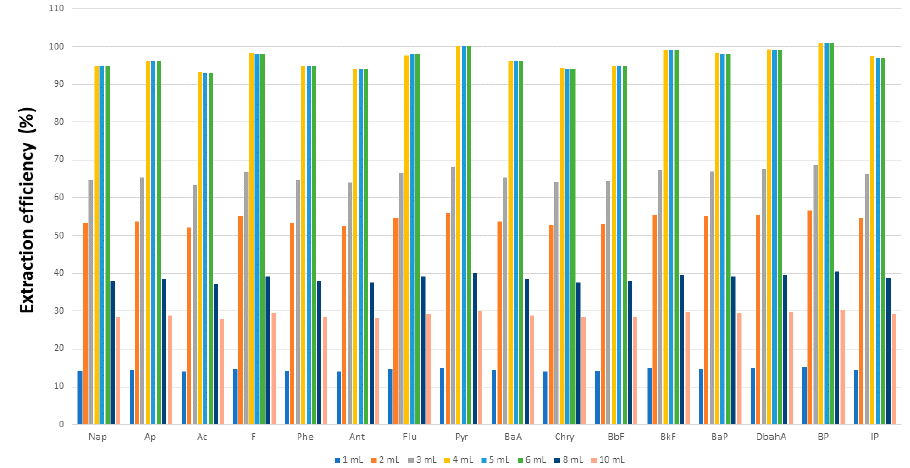
Figure 2. Influence of the volume of ethanol on the extraction of polycyclic aromatic hydrocarbons from dairy products.